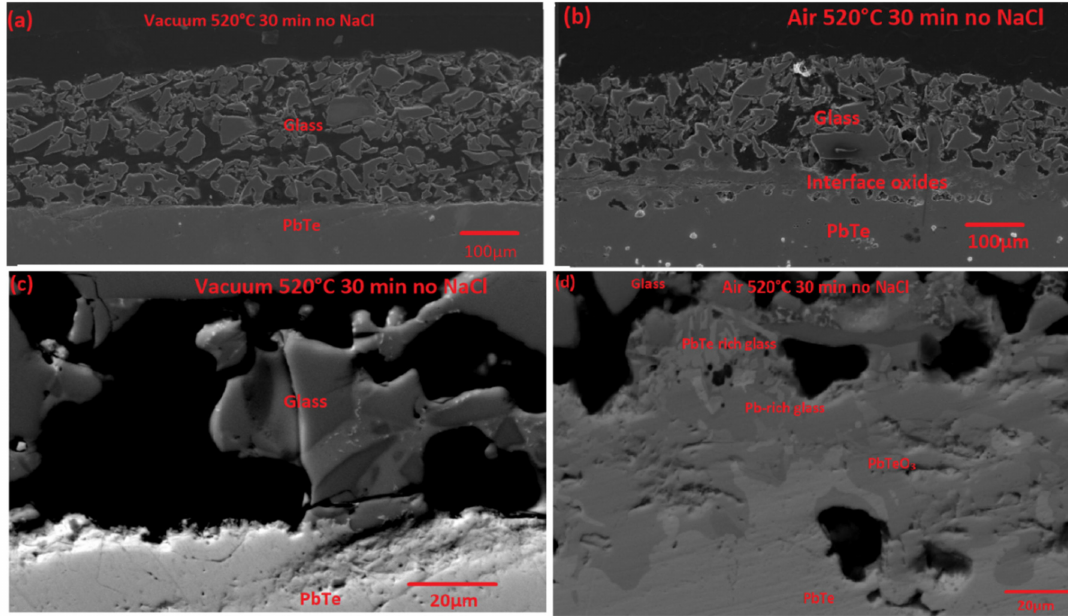
Figure 3. ( a ) SEM micrographs of glass coated PbTe, following 520 ◦ C / 30 min. thermal treatment under vacuum ( a , c ) and air ( b , d ) atmospheres. ( a , b ) are secondary electrons images while ( c , d ) are back scattered electrons